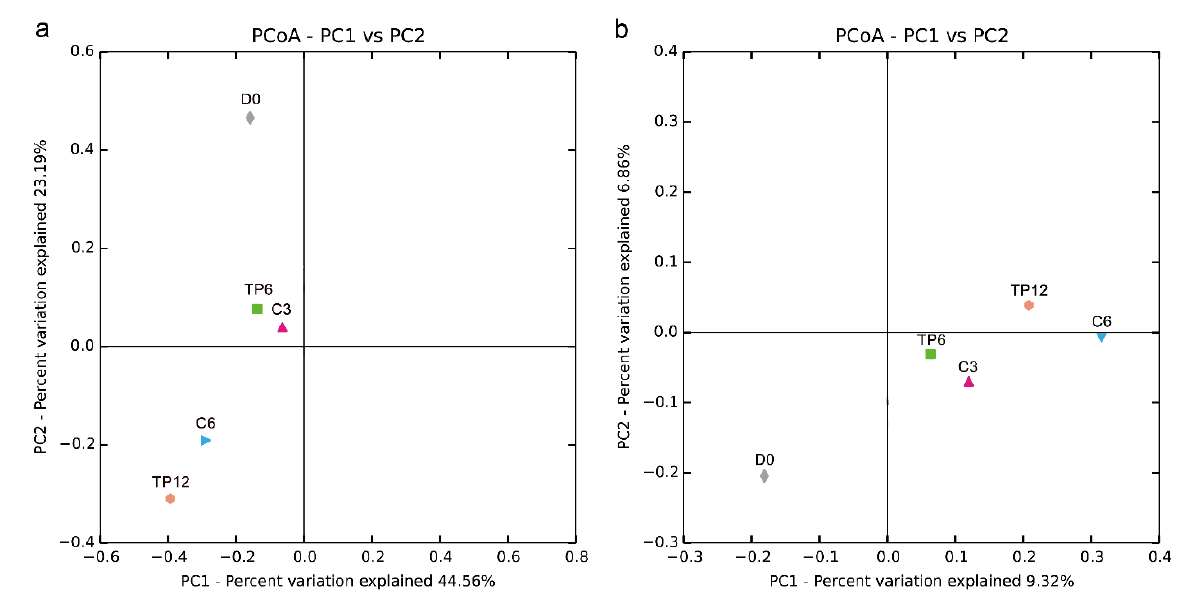
Figure 3. Principal coordinate analysis of the crisp grass carp fillet bacterial communities based on ( a ) weighted and ( b ) unweighted UniFrac metrics of samples during storage at 4 °C.